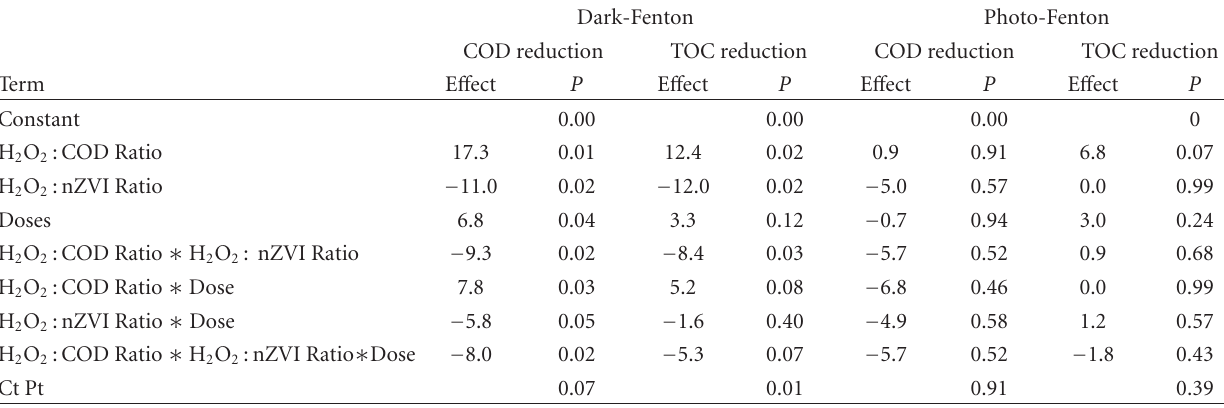
Table 5: Results of statistical analyses of independent